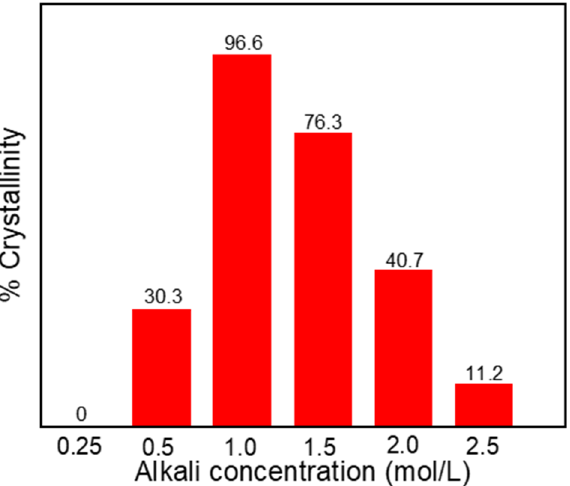
Figure 3. The crystallinity of samples synthesized at different NaOH concentrations of 0.25 mol·L − 1 , 0.5 mol·L − 1 , 1.0 mol·L − 1 , 1.5 mol·L − 1 , 2.0 mol·L − 1 and 2.5 mol·L − 1 .